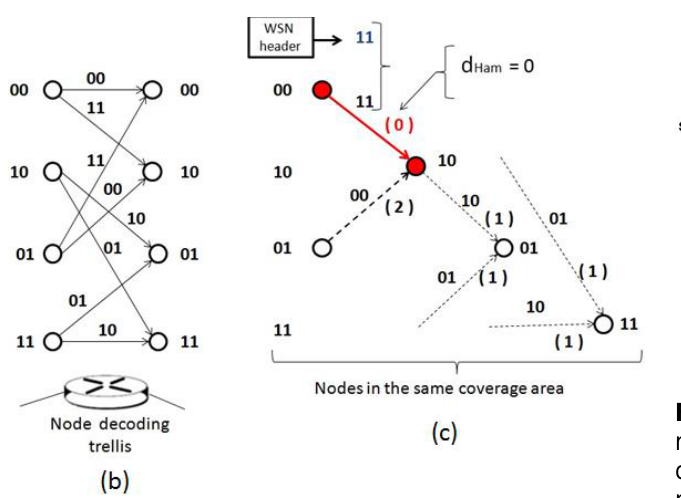
Figure 6. (a) TCNet FRAME initialization by the sink node; (b)Trellis decoder; (c) Nodes in the same coverage area.